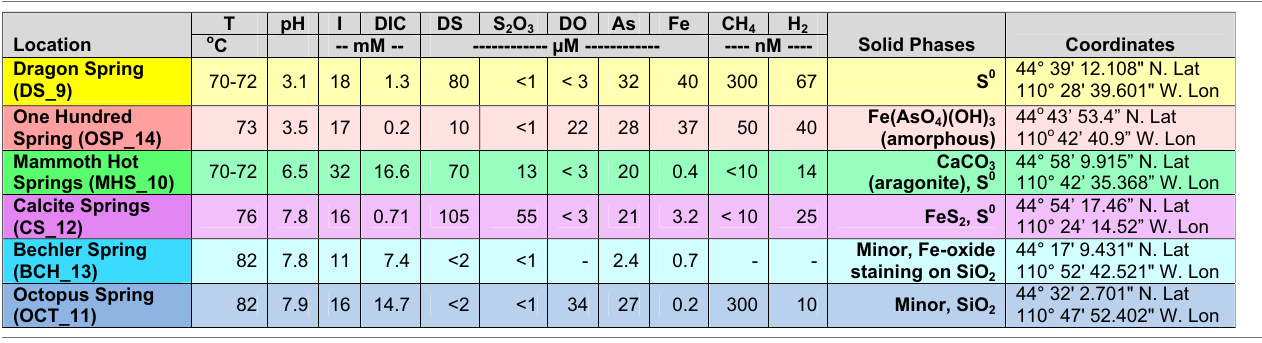
Table 1 | Sample location, aqueous geochemical parameters 1 and predominant solid-phases 2 associated with sixAquificales communities in Yellowstone National Park